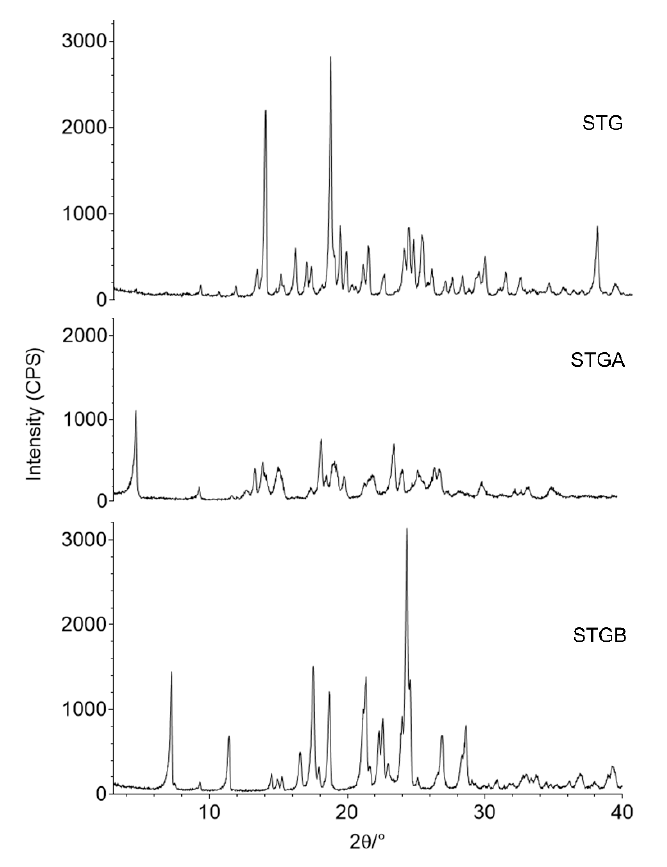
Figure 13. X-ray powder diffraction (XRPD) patterns for sitagliptin phosphate monohydrate (STG), sitagliptin phosphate anhydrous (STGA) and sitagliptin base form (STGB).